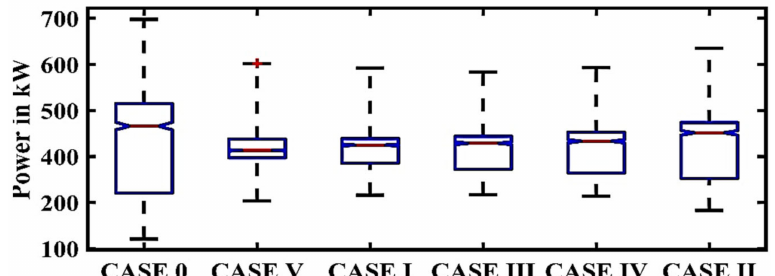
Figure 10. Grid power deviations (mean and variability) for different cases.